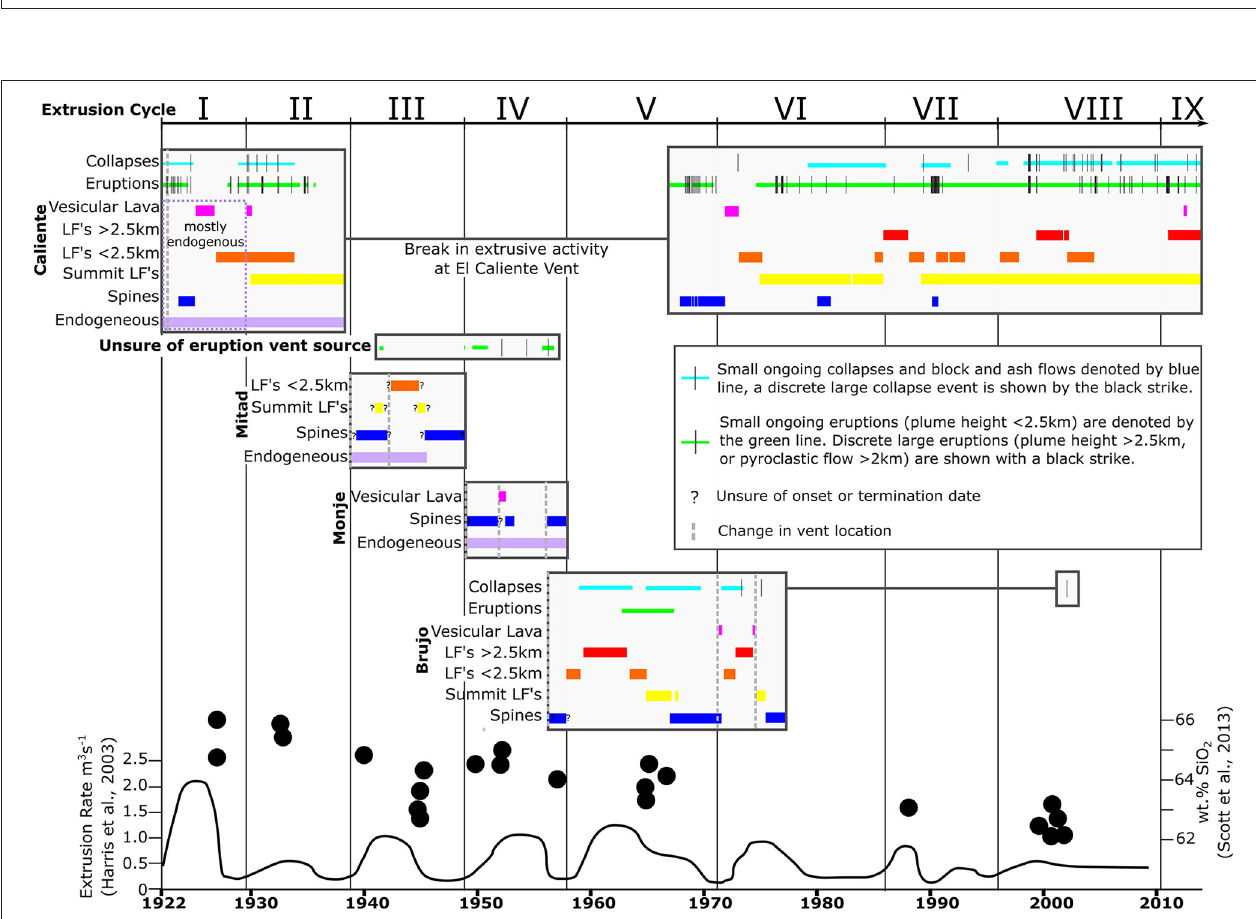
FIGURE 8 | Timing of extrusive activity and eruptive and collapse events at Santiaguito with reference to extrusion cycles (Harris et al., 2003), composition (Scott et al., 2013), and extrusion rate (Rose, 1973b; Harris et al., 2003).